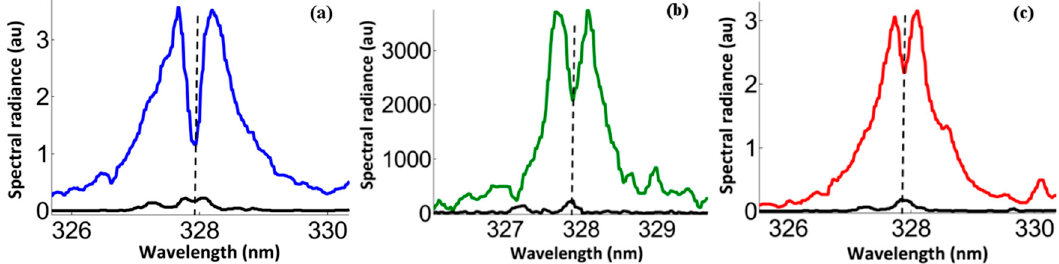
Figure 2. Self-reversal of the resonance Ag I line at 327.9 nm. Laser wavelengths: ( a ) 355 nm, ( b ) 532 nm, and ( c ) 1064 nm. The colored, larger, black, and lower plasma spectra are measured from nano-based and bulk silver targets,